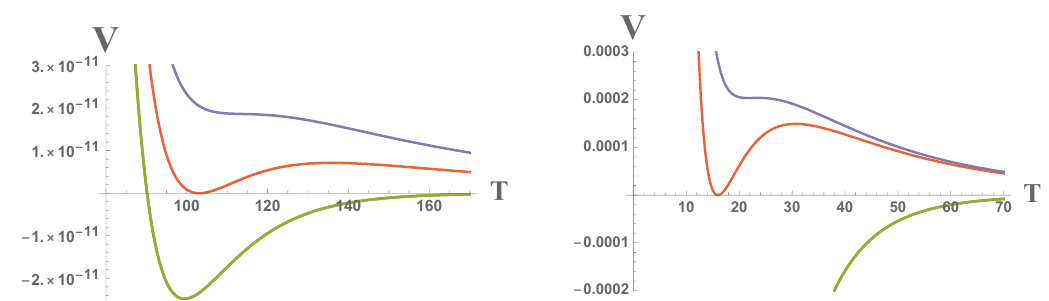
Figure 2 . A comparison of KKLT uplifting for A = 1, a = 2 (cid:25)= 100, for W 0 = 10 (cid:0) 2 (left panel) and W 0 = 10 2 (right panel). The green lines show the potential before the uplifting, the red lines show the potential with a dS minimum with a tiny positive cosmological constant. The blue lines illustrate the disappearance of the minimum if the uplifting is too large, which may result in decompacti(cid:12)cation of 6 extra dimensions in the early